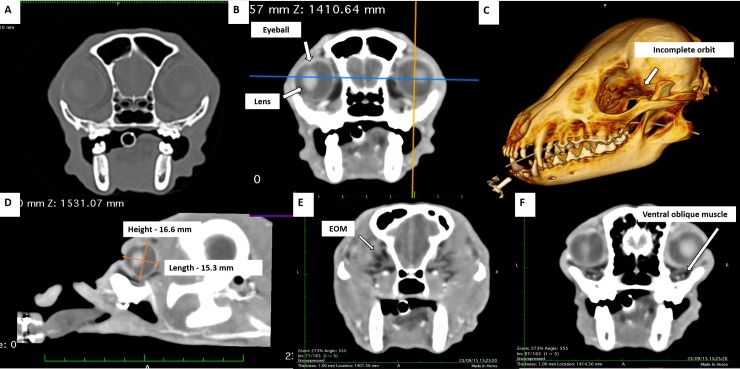
CT images of the eye and adnexa of crab-eating fox.Axial (transverse) plane image (A) without contrast, in bone window and (B) with contrast, in soft tissue window, where the eyeball contour, hypoattenuating internal content and hyperattenuating lens are evident. (C) Tridimensional bone reconstruction, with suppression of the soft tissues, showing the incomplete orbit (arrow). (D) Sagittal plane reconstruction image, in soft tissue window, showing the height and length of the eyeball (orange arrows). Contrast images in axial plane and soft tissue window (E) of the extraocular muscles (EOM) and (F) showing the pathway of the ventral oblique muscle.